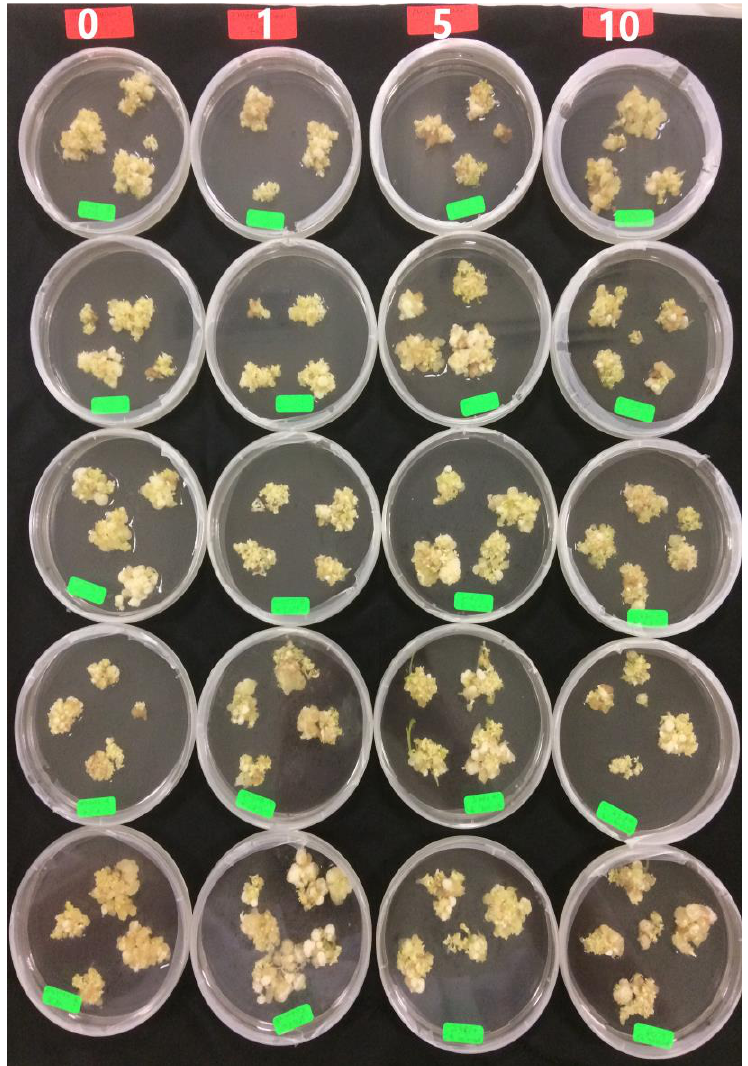
Figure 6. Embryogenic callus after 6 weeks on maturation media supplemented with different concentrations of phloroglucinol (PG) (0, 1, 5, 10 mg L − 1 ) (M6–M9).